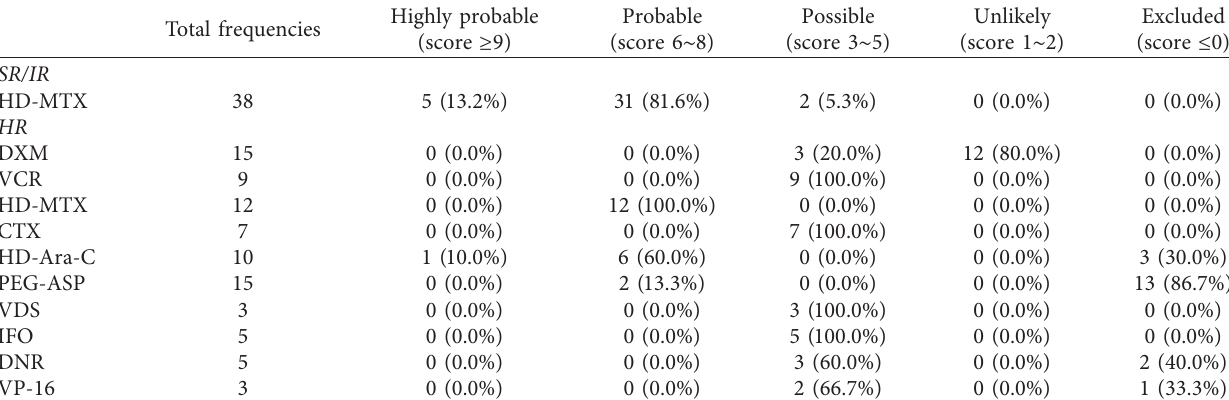
Table 6: Distribution of final scores of suspected agents in DILI cases using the updated RUCAM [6].